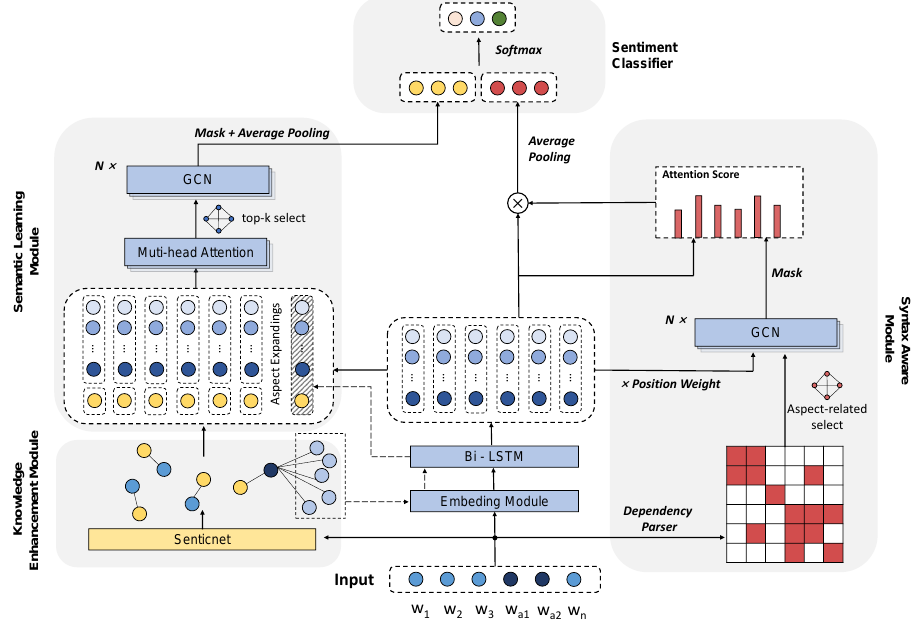
Figure 3. Overall architecture of the proposed Knowledge-Enhanced Dual-Channel Graph Convolu- tional